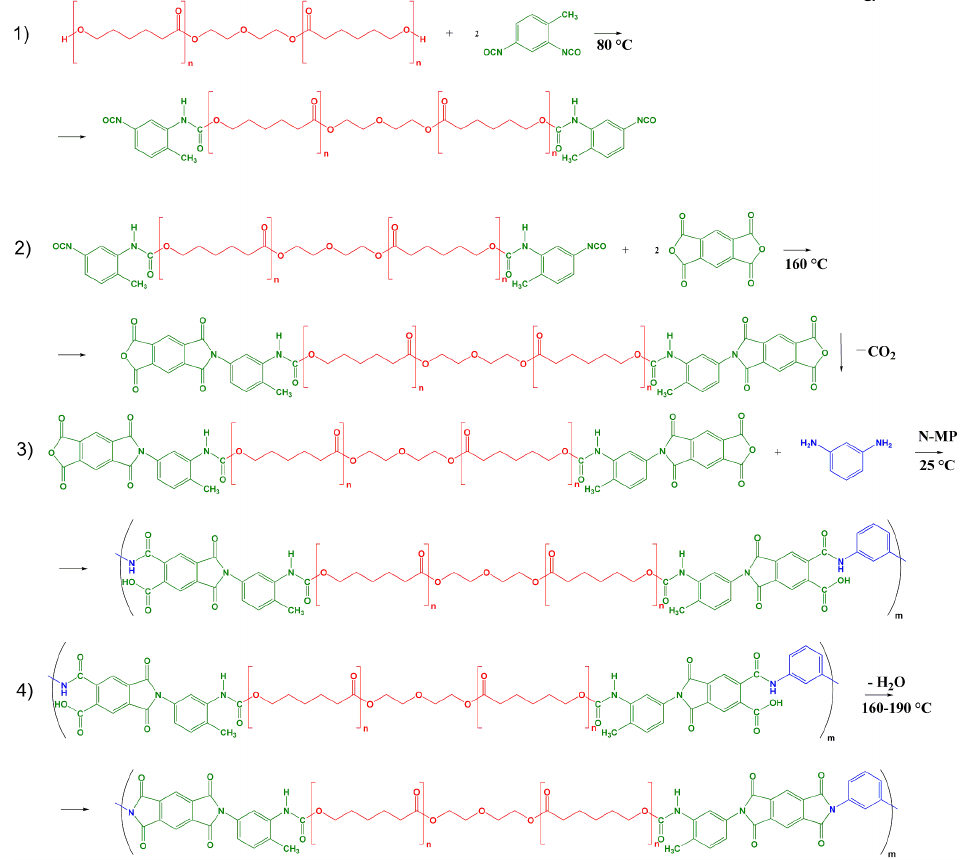
Figure 1. Scheme of the synthesis of segmented poly(urethane-imide)s (PUIs).